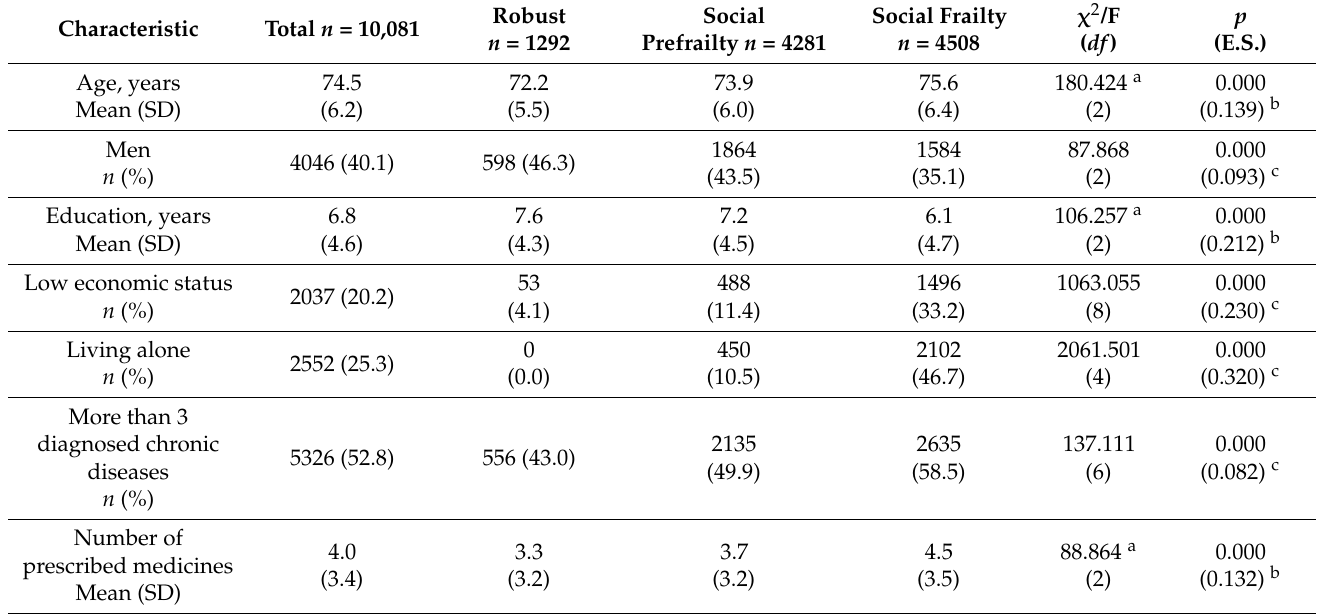
Table 1. General characteristics of participants in the robust, social prefrailty, and social frailty groups.